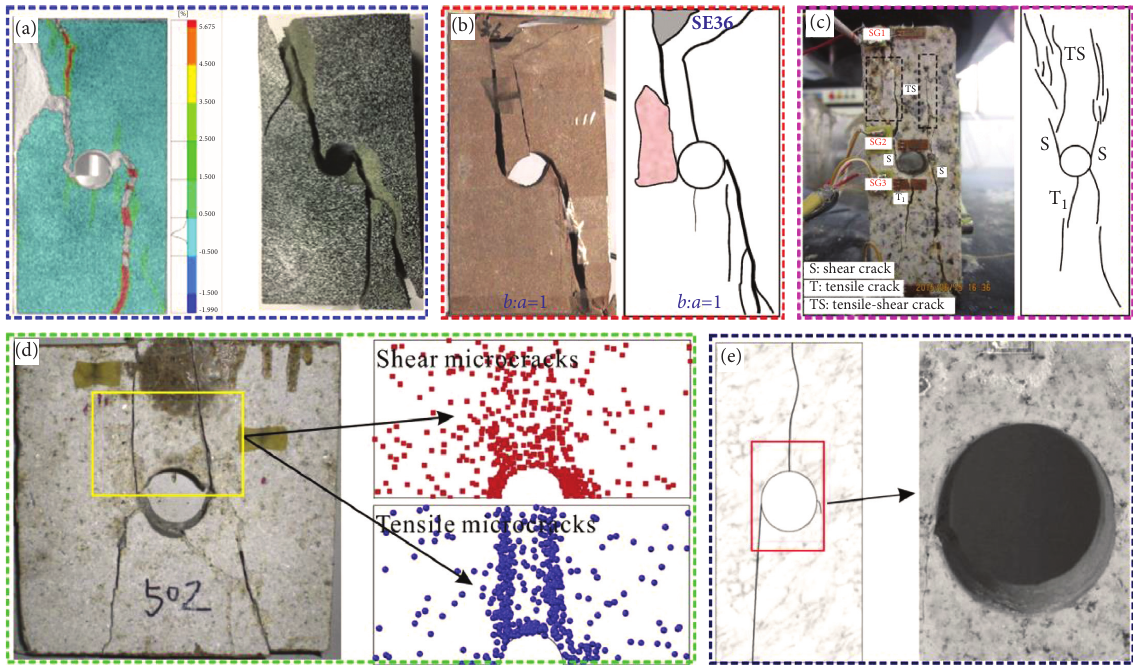
Figure 19: Failure patterns of samples with a circular cavity obtained from different experiments under uniaxial loading: (a) after Zhu et al. [18]; (b) after Huang et al. [21]; (c) after Weng et al. [16]; (d) after Liu et al. [30]; (e) after Xu et al.